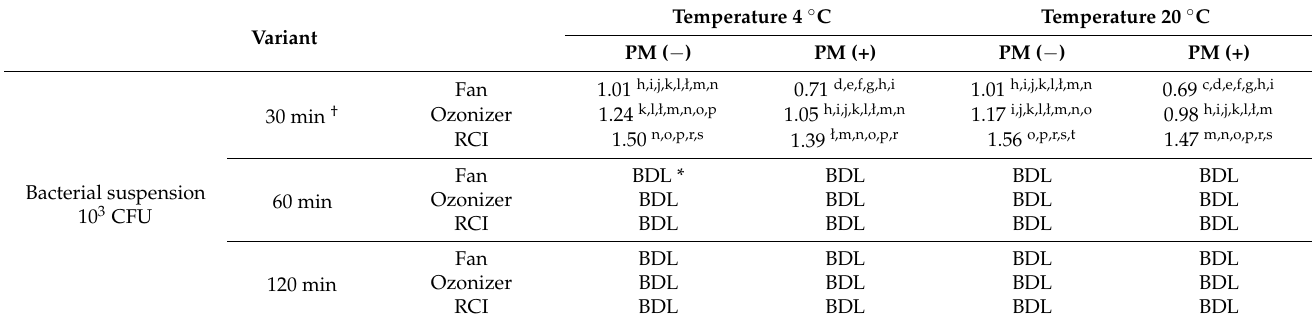
Table 2. Decrease in the number of bacteria [log CFU/egg] on eggshells after